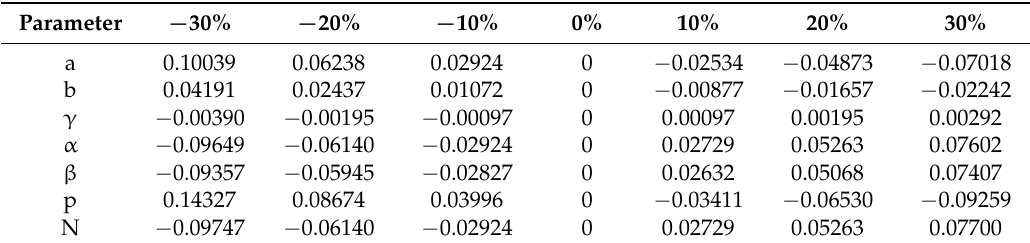
Table 11. Sensitivity analysis for parameters of the optimal release time.